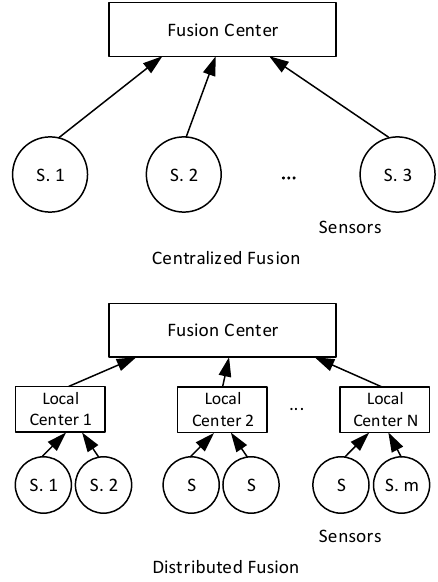
Figure 6. Centralized Fusion and Distributed Fusion. In centralized fusion, all measurements are sent to the fusion center; while in distributed fusion, the sensors supply data to a set of local processors to conduct pretreatment firstly, and then the result will be sent to the fusion center for a global estimate.